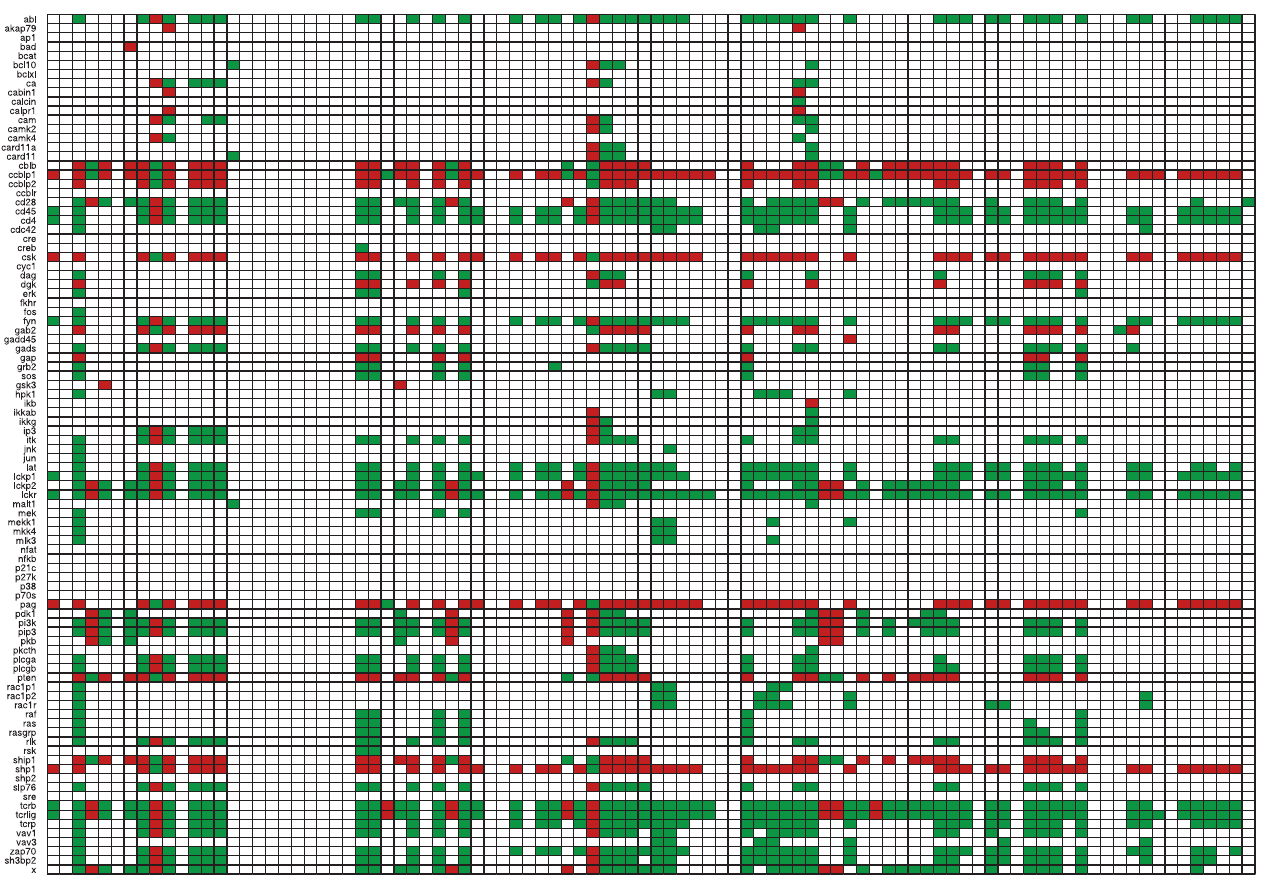
Figure 2. Dependency Matrix of the Logical T Cell Signaling Model (Figure 1) for the Early Events Scenario ( s ¼ 1) The color of a matrix element M xy has the following meaning [13]: (i) dark green: x is a total activator of y; (ii) dark red: x is a total inhibitor of y; (iii) white: no (direct or indirect) influence from x on y.